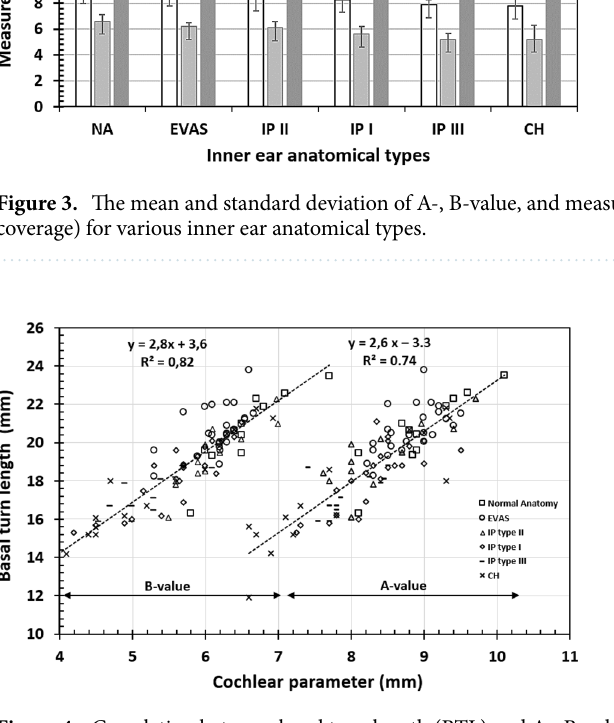
Figure 4. Correlation between basal turn length (BTL) and A-, B-values of all the anatomical types taken for